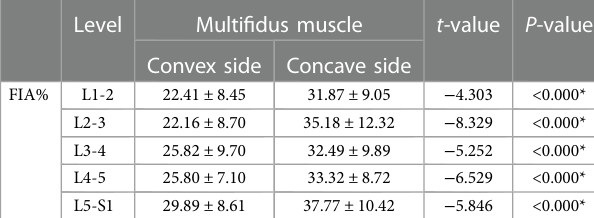
TABLE 2 The FIA% of the multi fi dus muscle on the concave and convex sides in the PI-LL match